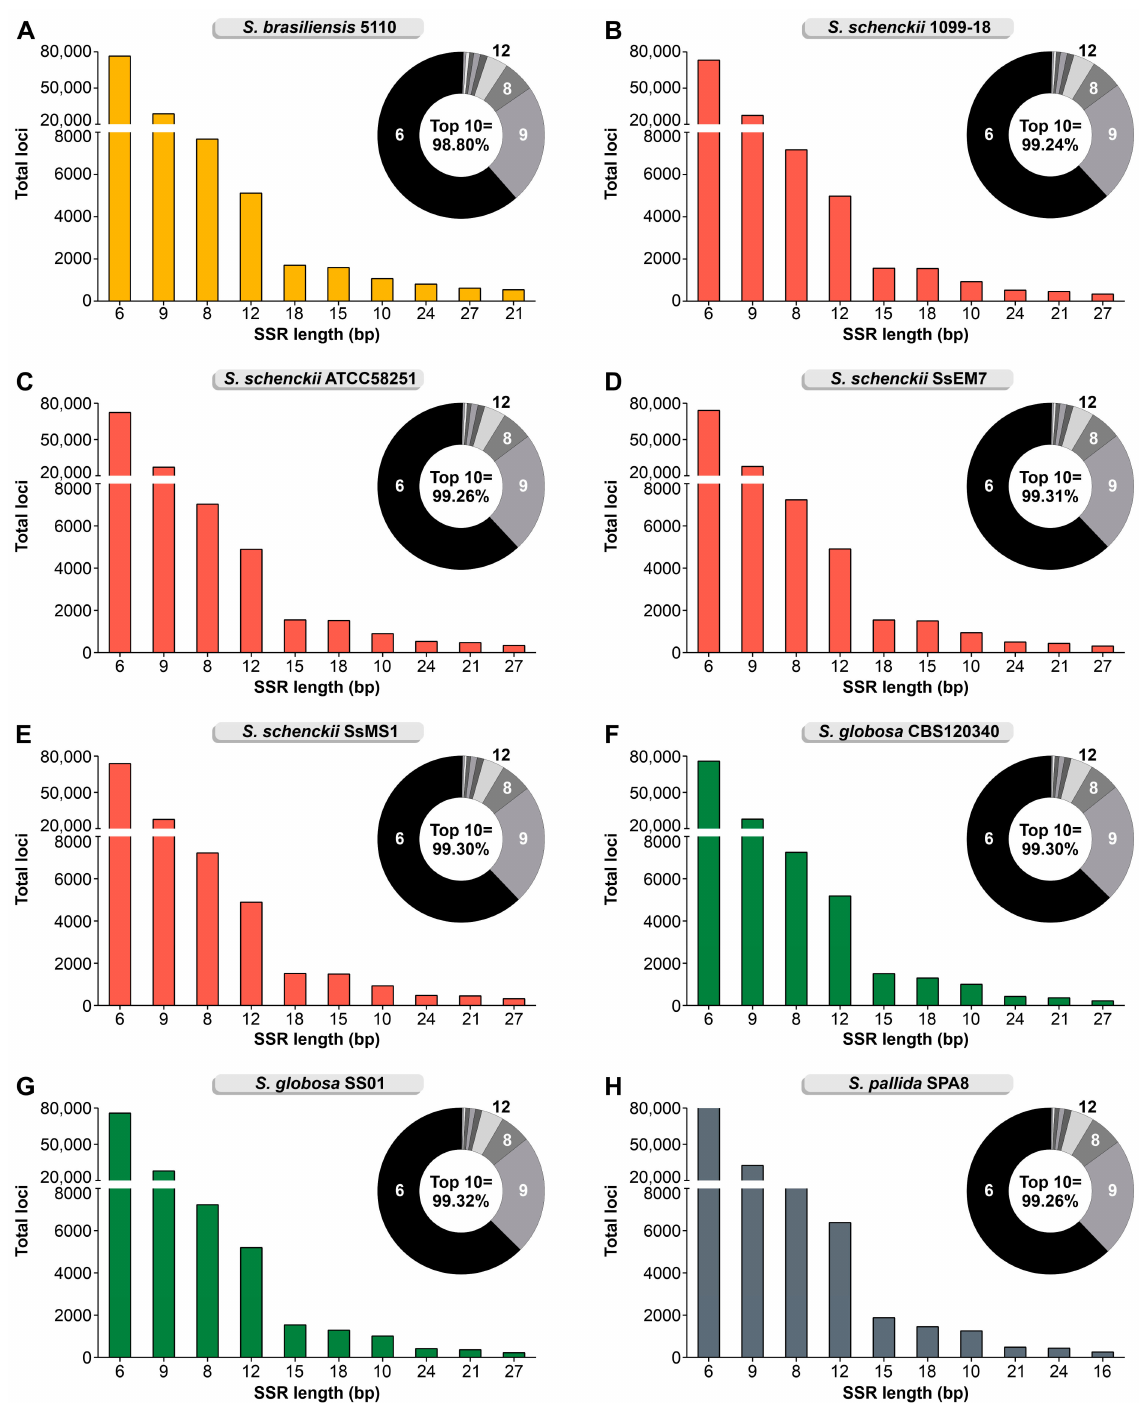
Figure 3. SSR length distribution with a minimum of 3 repeats and motifs of 2–10 bp shows that 6 bp, 9 bp, 8 bp, and 12 bp are the major SSR in Sporothrix : ( A ) S. brasiliensis 5110; ( B ) S. schenckii 1099-18; ( C ) S. schenckii ATCC58251; ( D ) S. schenckii SsEM7; ( E ) S. schenckii SsMS1; ( F ) S. globosa CBS 120340; ( G ) S. globosa SS01; ( H ) S. pallida